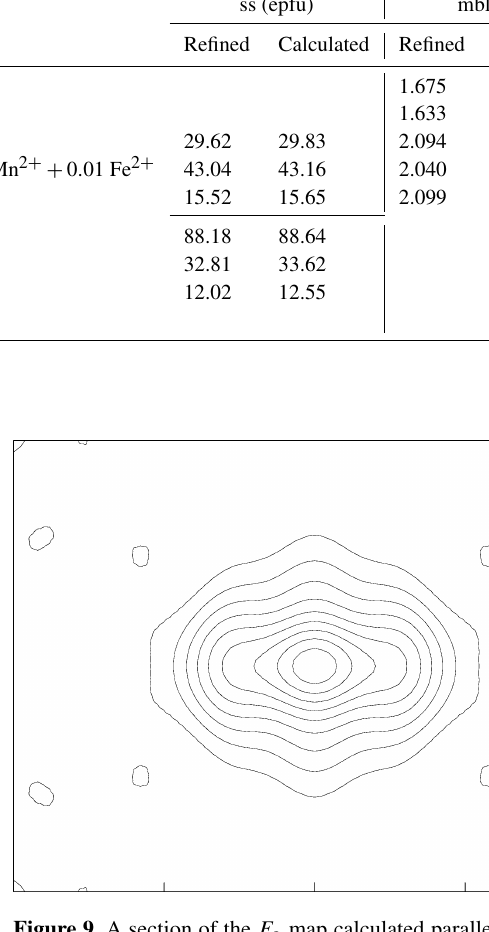
Figure 9. A section of the F o map calculated parallel to (201) and centred at 0, 1 / 2, 0 for ferri-taramite, showing the distribution of the electron density within the A cavity. The b axis is horizontal, − 1 and contours are drawn with steps of 1 e Å starting from